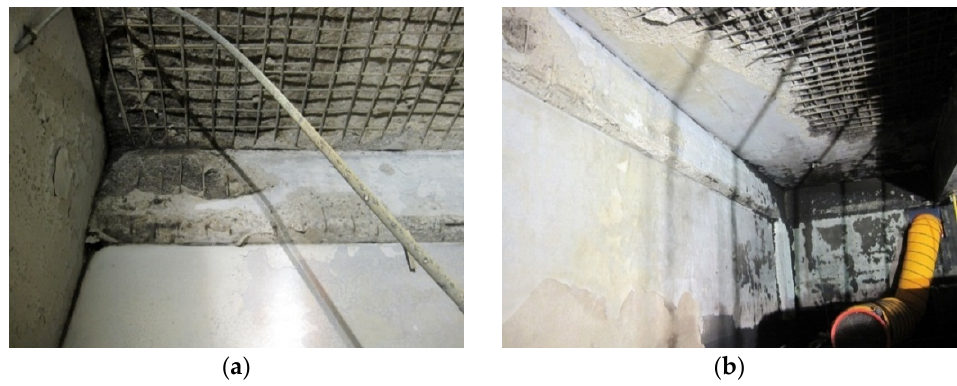
Figure 5. Damage to Girder #1. ( a ) Exposed stirrups in the north region. ( b ) West side of girder seen from the north.